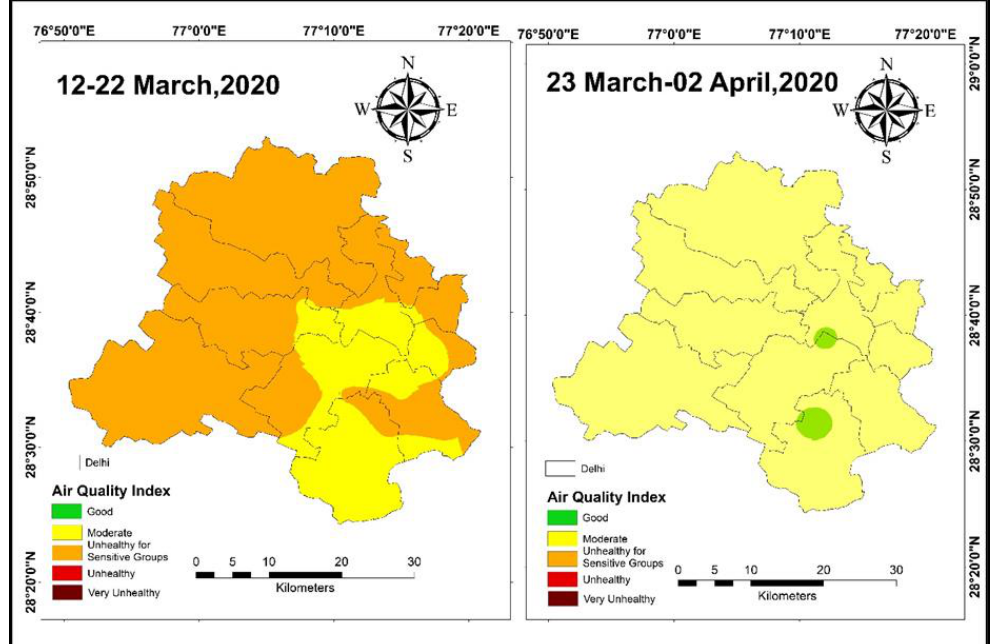
Figure 9. AQI map of PM 10 before (12–22 March 2020) and during the lockdown (23 March–2 April, 2020).